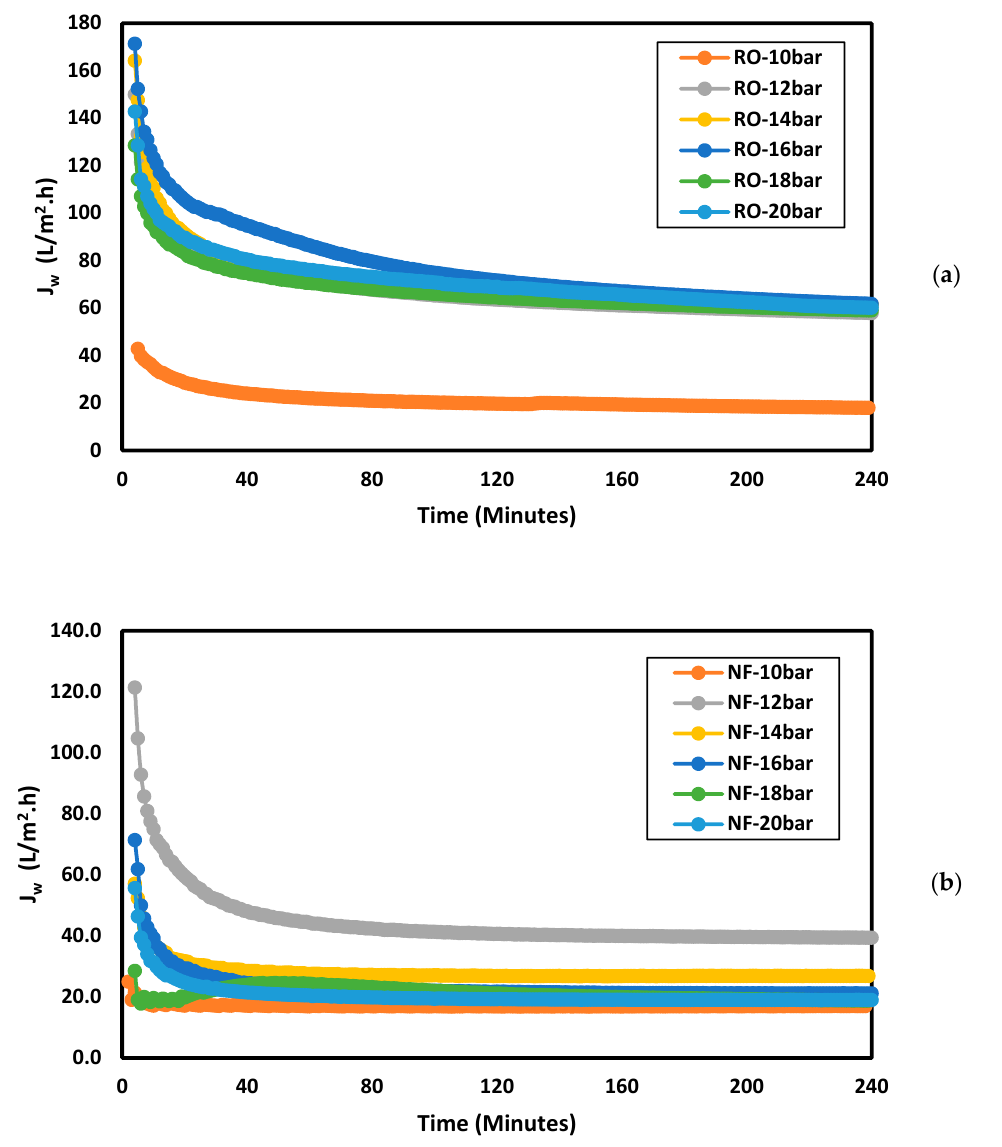
Figure 2. Water flux using treated sewage effluent (TSE) as feed water at different applied pressures in ( a ) reverse osmosis ( b ) nanofiltration.